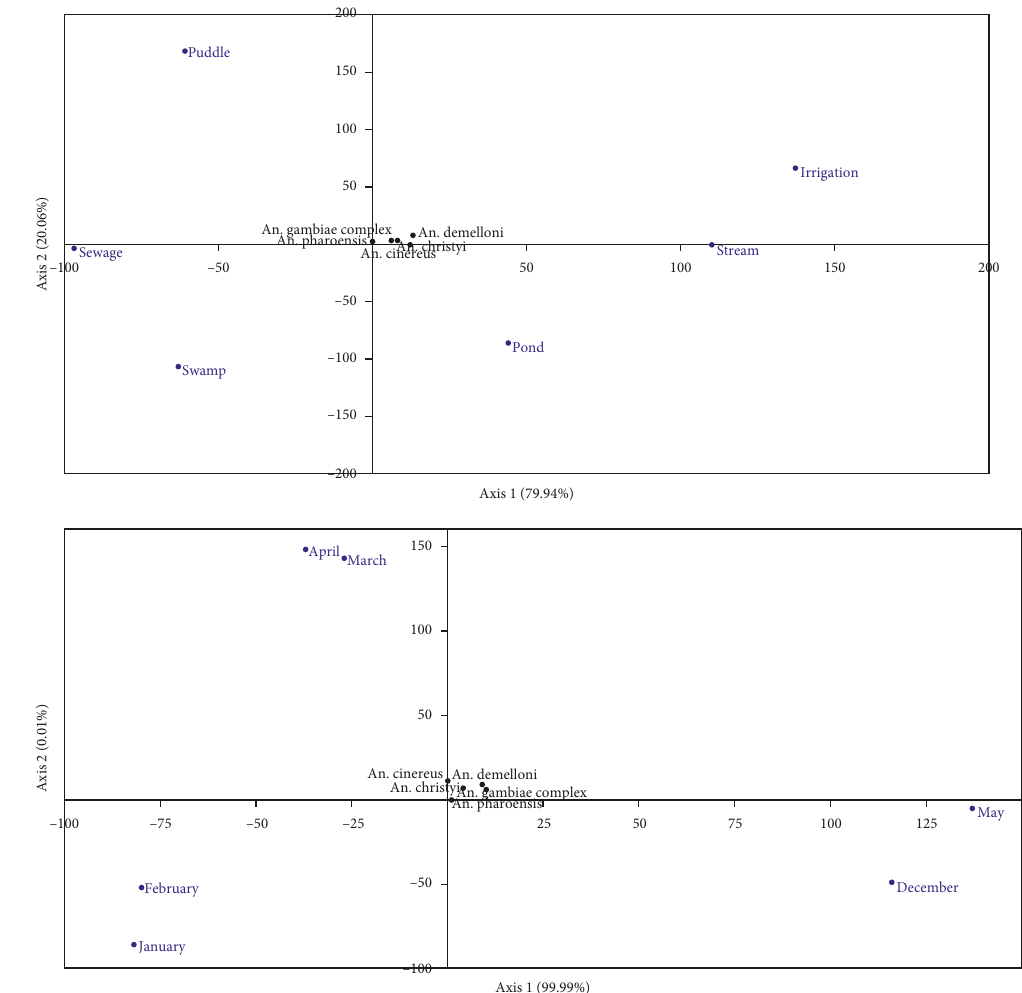
Figure 2: Detrended correspondence analysis between species abundance and time factor (months across the